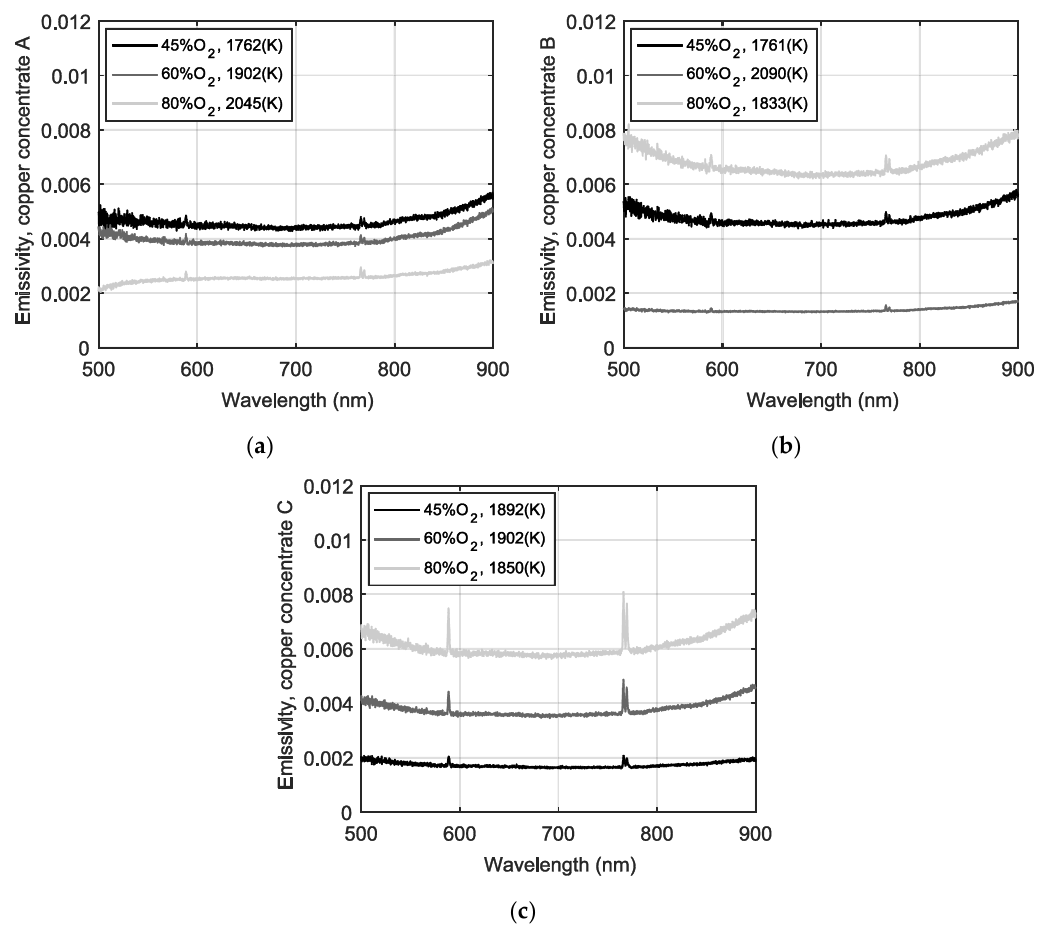
Figure 6 . Spectral emissivity during the flash smelting process, for three different copper concentrates of a: ( a ) S/Cu ratio of 1.07; ( b ) S/Cu ratio of 1.27 and ( c ) S/Cu of 1.85.